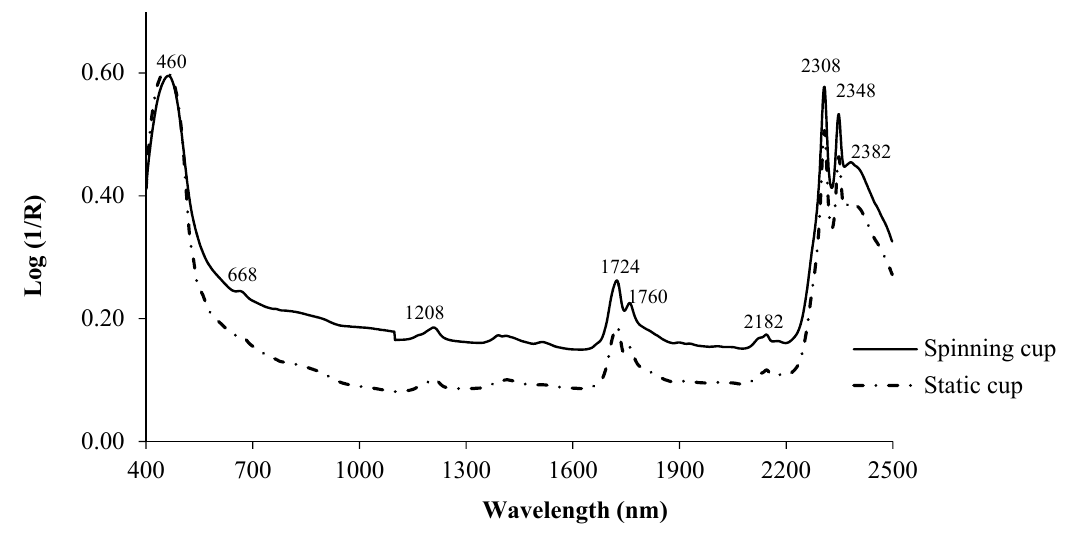
Figure 1. Log (1/R) for olive oil using the spinning and static cups.